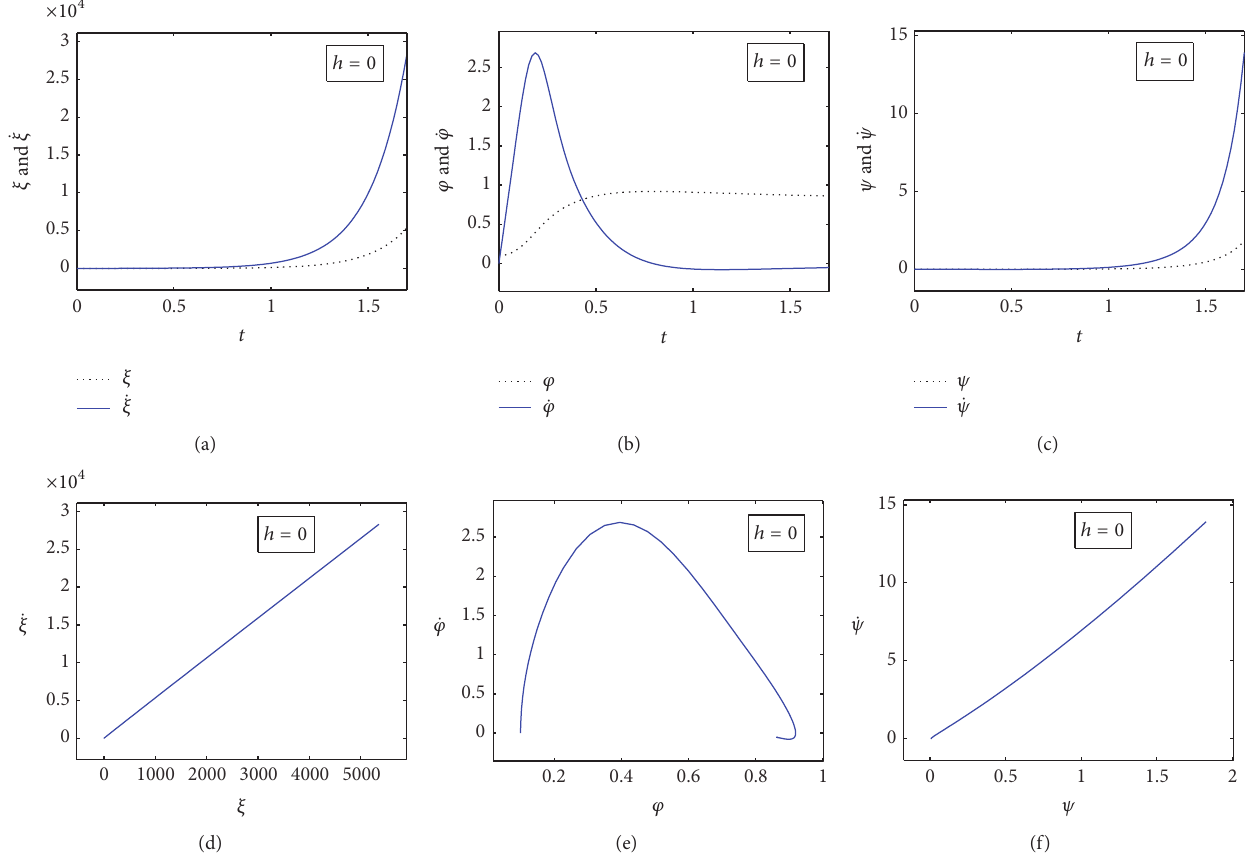
̇𝜉, ̇𝜑 , and ̇𝜓 via time 𝑡 , respectively, when 𝑏 = 3 m,